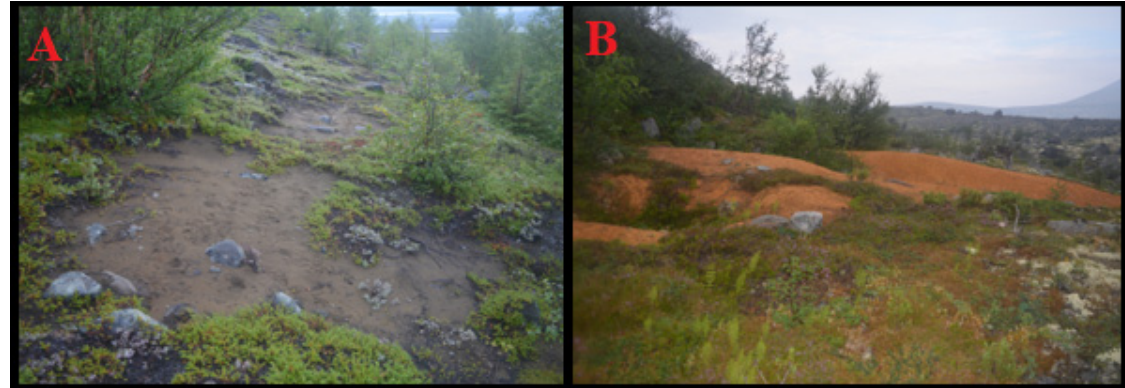
Figure 5. Photographs of soils from the Monchepluton area: ( A )—initial soils based on regolith in the Kumuzhia area; ( B )—a weathering cap over a chromite occurrence.